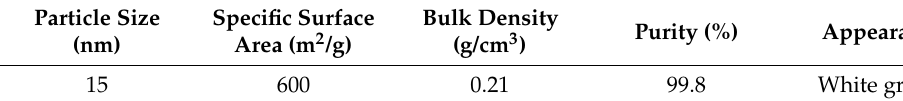
Table 2. Basic technical properties of N ‐ S.